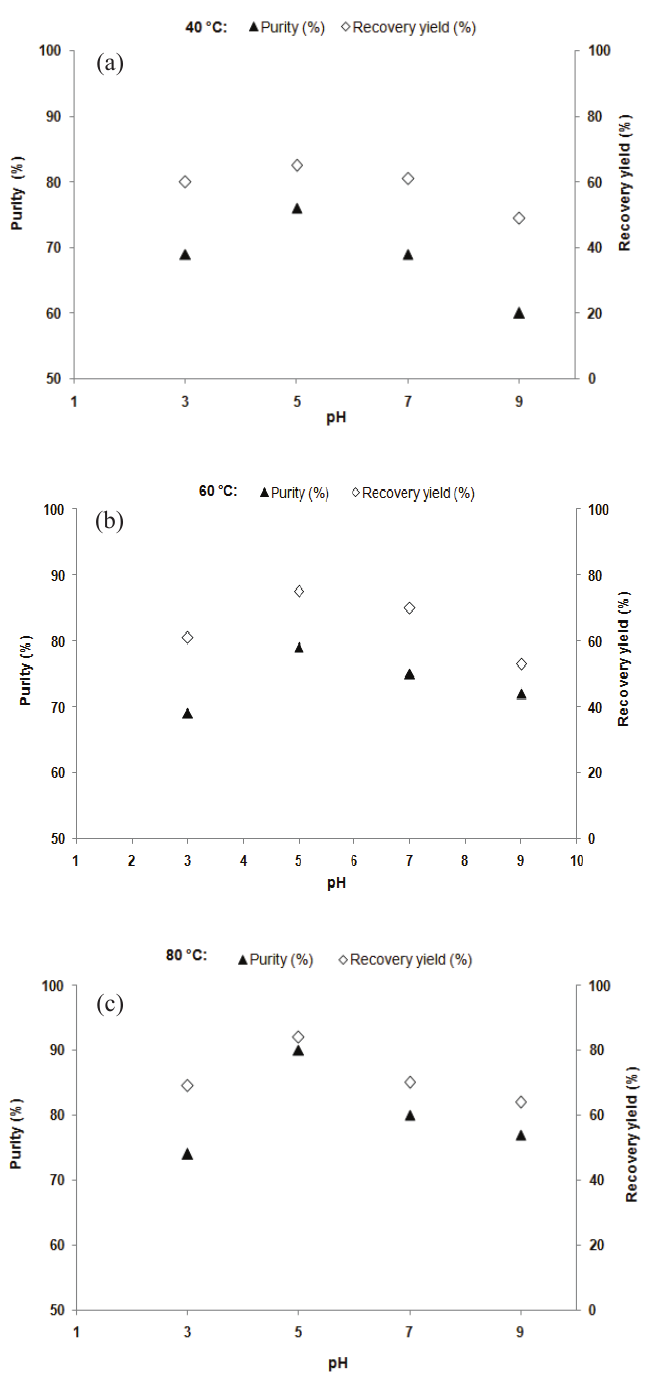
Fig. 3 – Effect of different pH on purity and recovery yield (%) with LAS-99 extraction at a) 40 °C incubation tempera- ture; b) 60 °C incubation temperature; c) 80 °C incubation